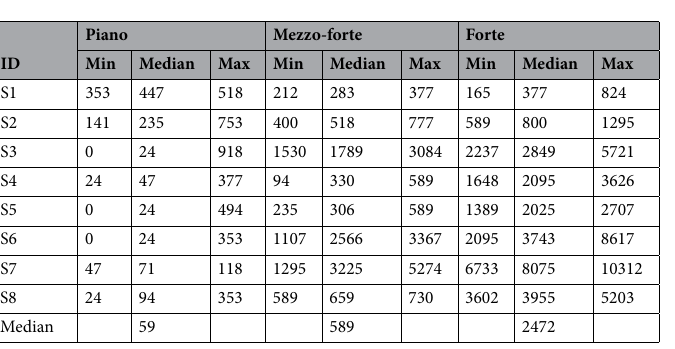
Table 3. Minimum, maximum, and median values of emission rates in particles/sec for piano, mezzo-forte, and forte based on five test replications per test condition (cumulative values for all size classes > 0.3 µm).